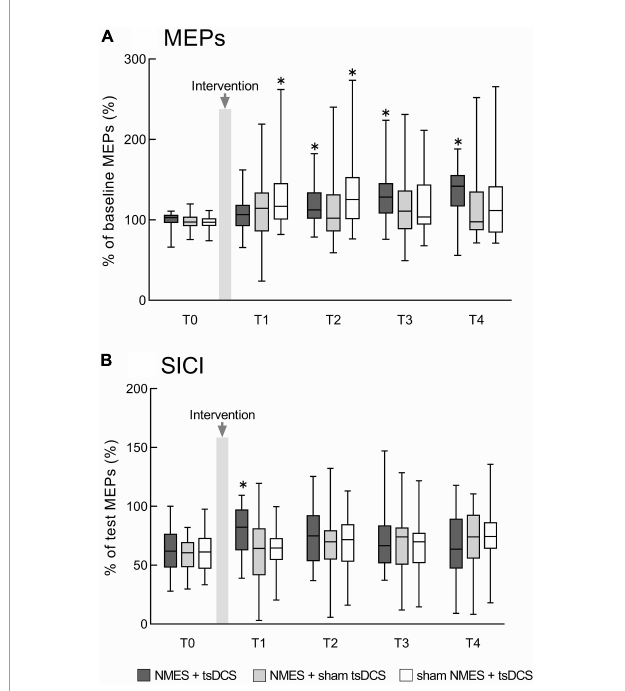
FIGURE3 The combined effects of neuromuscular electrical stimulation (NMES) and transcutaneous spinal direct current stimulation (tsDCS) on motor evoked potentials (MEPs) and short-interval intracortical inhibition (SICI). (A) Represents the MEPs changes before and after the intervention. MEP amplitudes were normalized to baseline MEP amplitudes. (B) Represents the SICI changes before and after the intervention. Conditioned MEP amplitudes were normalized to test MEP amplitudes to calculate SICI. NMES + tsDCS is denoted as dark gray boxes, NMES + sham tsDCS is denoted as light gray boxes, and sham NMES + tsDCS is denoted as white boxes. The median value and interquartile ranges are represented by horizontal lines within boxes and whiskers representing minimum and maximum values, respectively. Asterisks indicate significant differences compared to “T0” ( P <